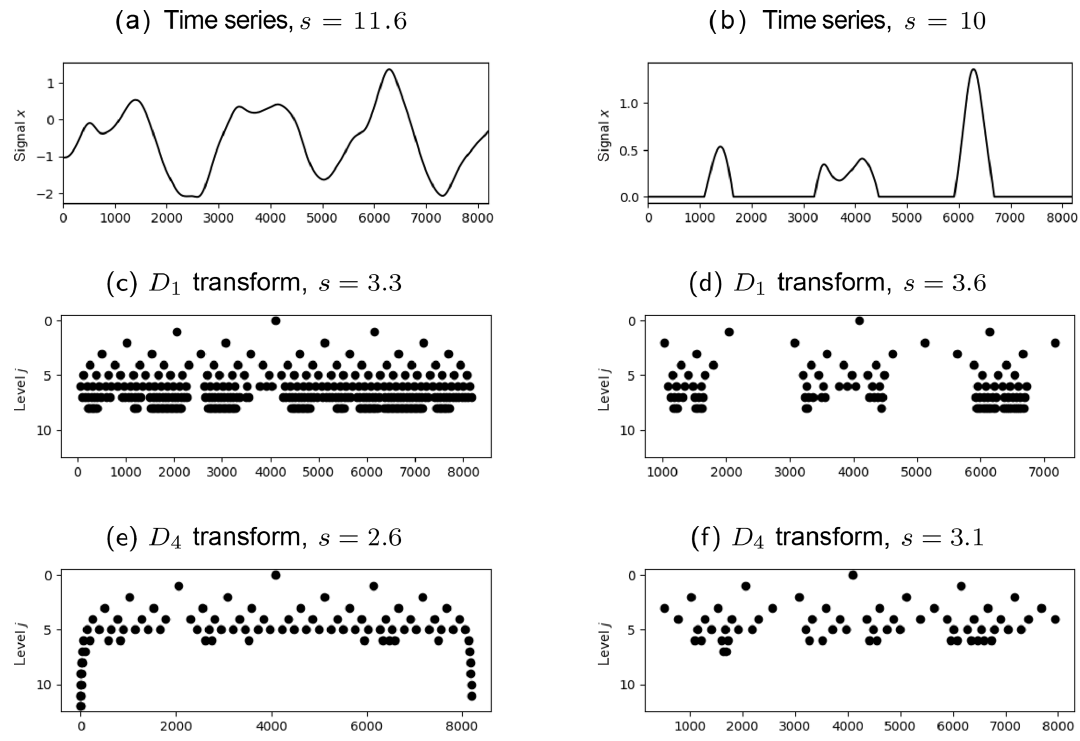
Figure A1. Realization of a one-dimensional Gaussian random vector with covariance M(ν = 3 . 5 ,b = 2 ) (a) and the corresponding values of the D 1 transform and least asymmetric D 4 transform (c, e) which are greater than 0 . 1. Panels (b) , (d) , and (f) are the corresponding plots for the cases where the vector is cut off at zero.